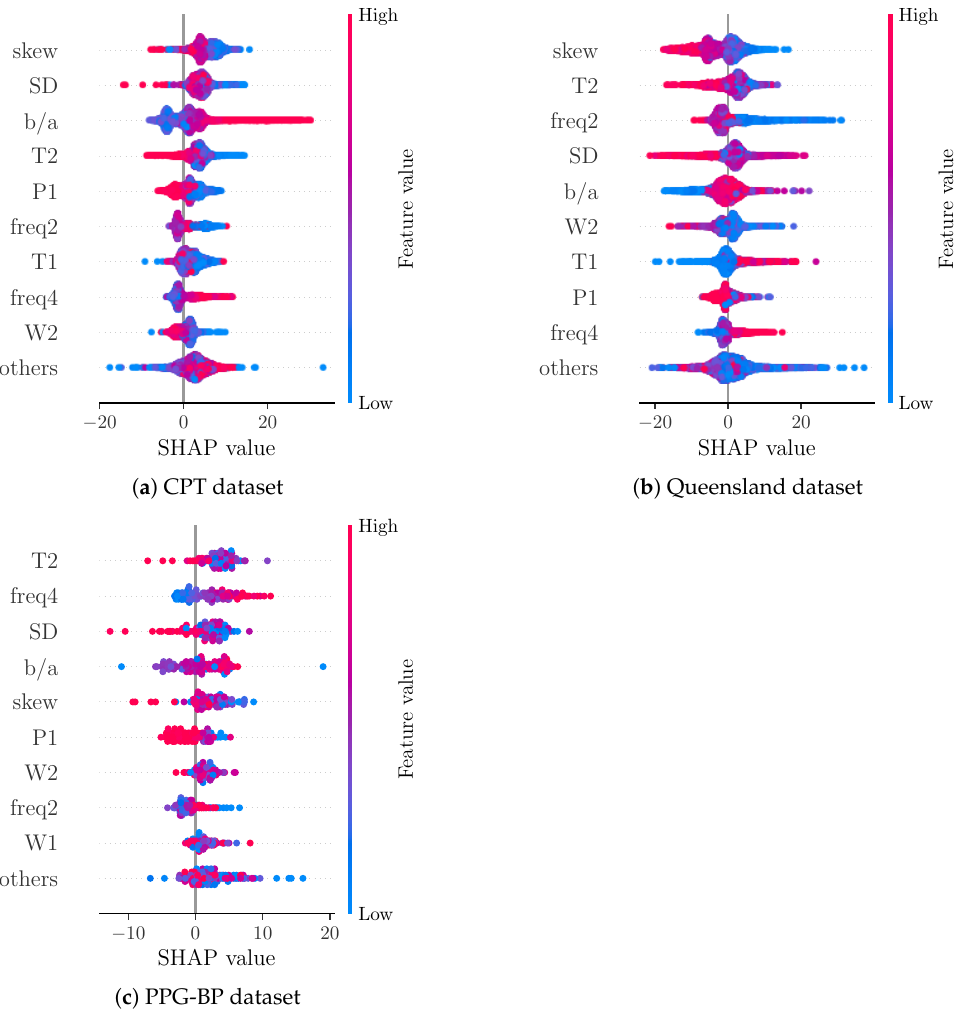
Figure 7. Beeswarm plot of SHAP values for subsets of samples of test set according to the